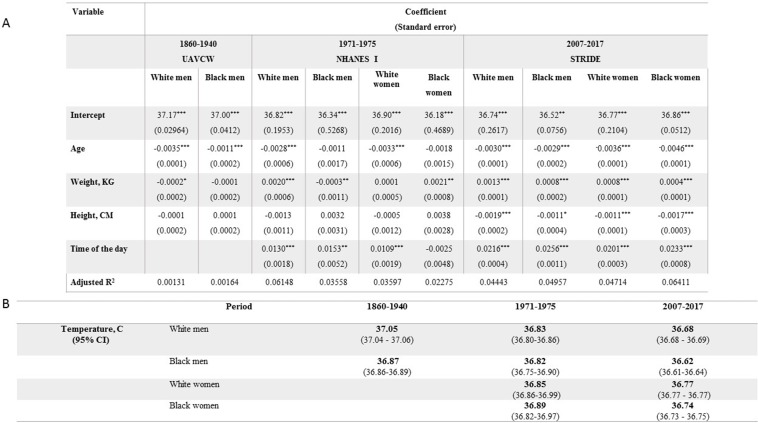
Model of mean body temperature in black and white ethnicity groups in three different time periods (cohorts): 1860–1940 (UAVCW), 1971–1975 (NHANES 1), and 2007–2017 (STRIDE).(A) Coefficients (and standard errors) from multivariate linear regression models for each cohort including age, body weight, height and time of day. Separate regression models were fitted for men and women, in black and white ethnicity groups. NHANES I includes population weights. *, **, *** indicates significance at the 90%, 95%, and 99% level, respectively. (B) Expected body temperature (and associated 95% confidence interval) for 30 year old men and women with body weight 70 kg and height 170 cm in each time period/cohort. These values derive from the regression models presented in A.Figure 1—figure supplement 3—source code 1.R code for Figure 1—figure supplement 3.